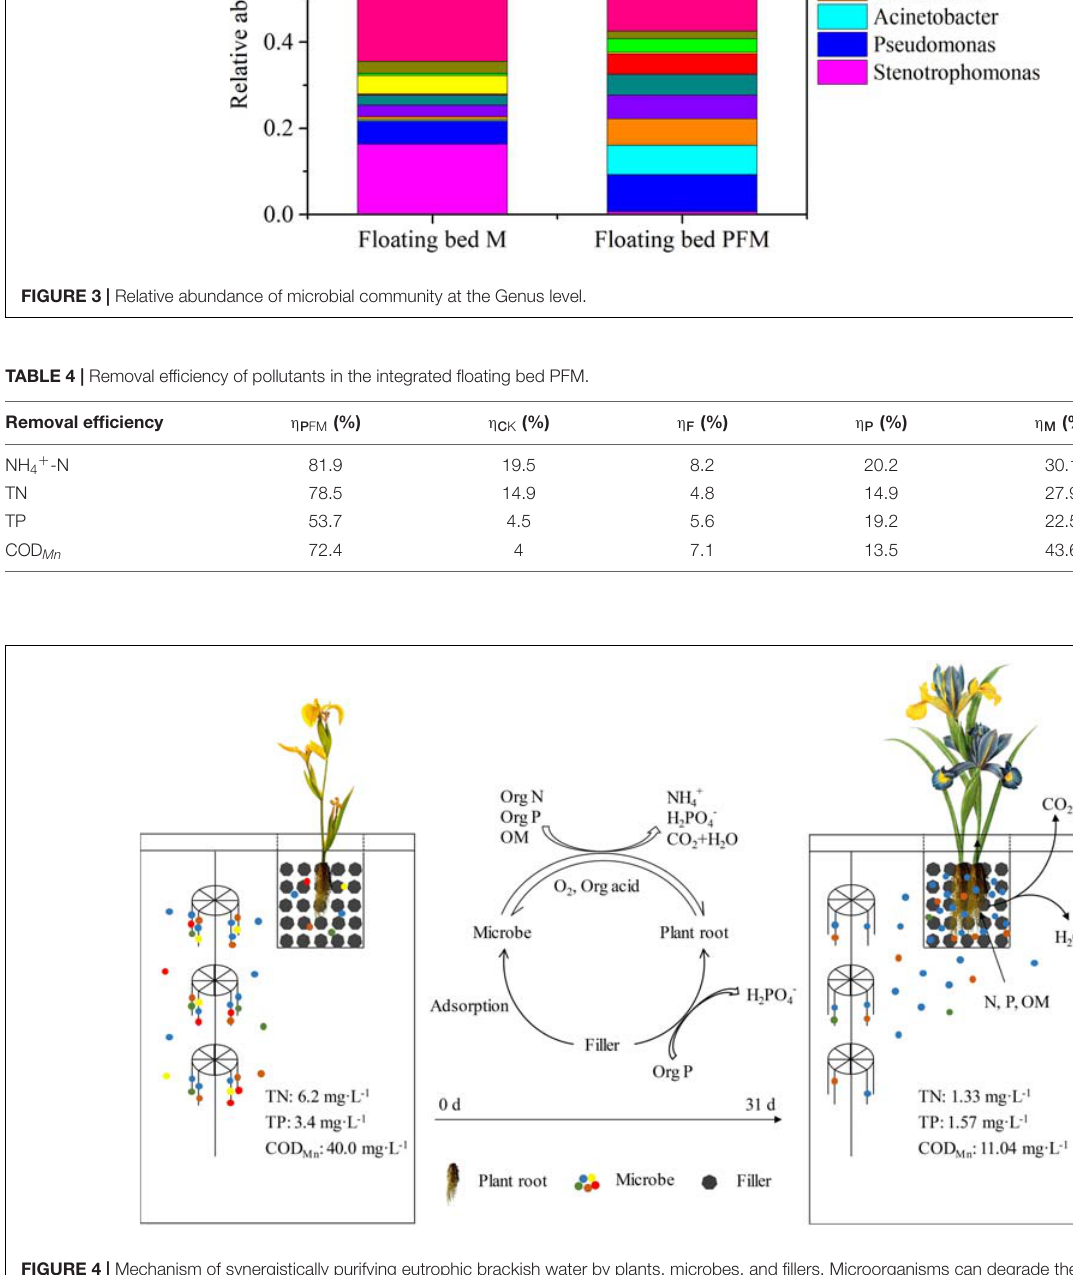
Frontiers in Marine Science |